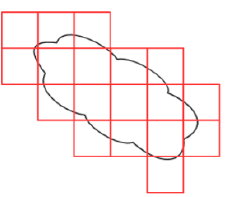
Figure 2. Patches representation of an image object (the black line refers to an image object and the red lines represent patches).